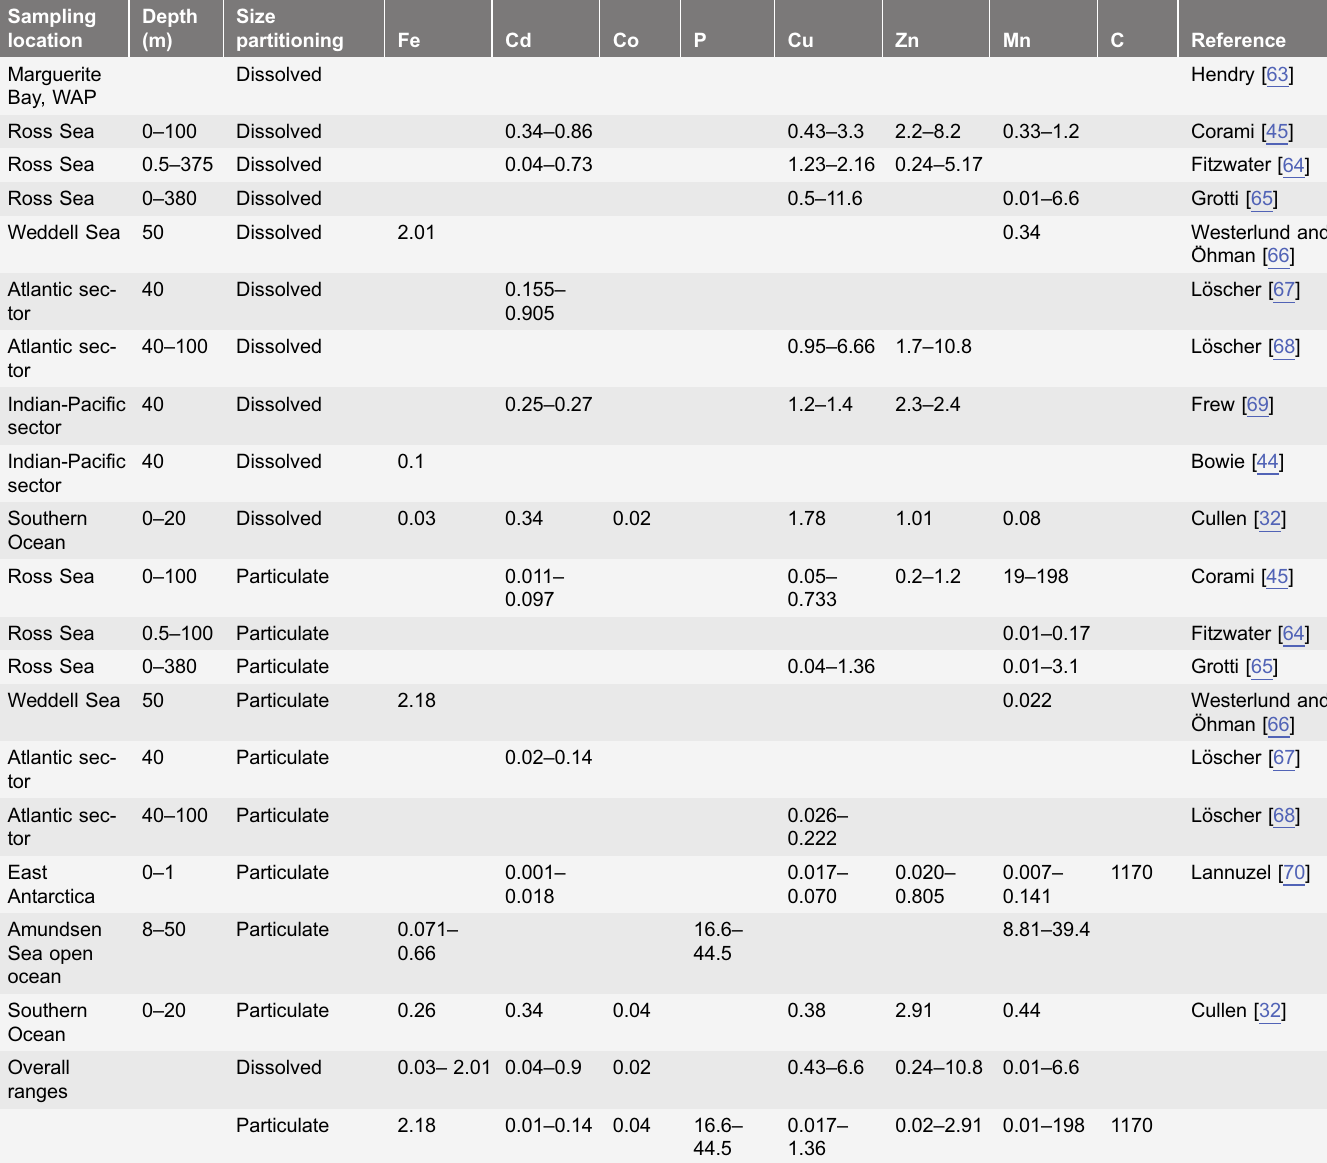
Data from Frew [69] and Bowie [44] in the Australasian-Pacific sector are from non-fertilised surface